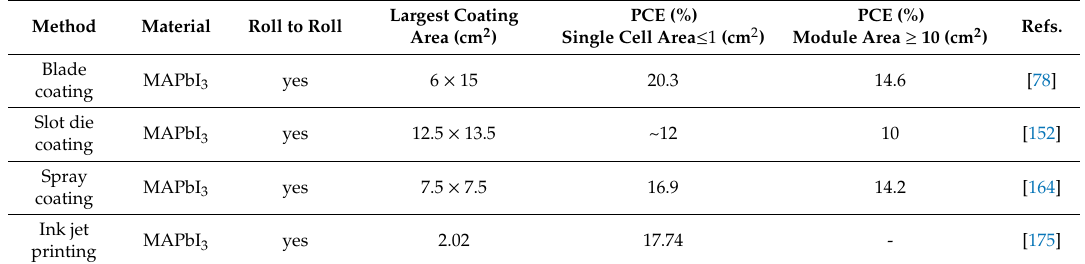
Table 1. A summary of scalable solution processing technologies for perovskite solar